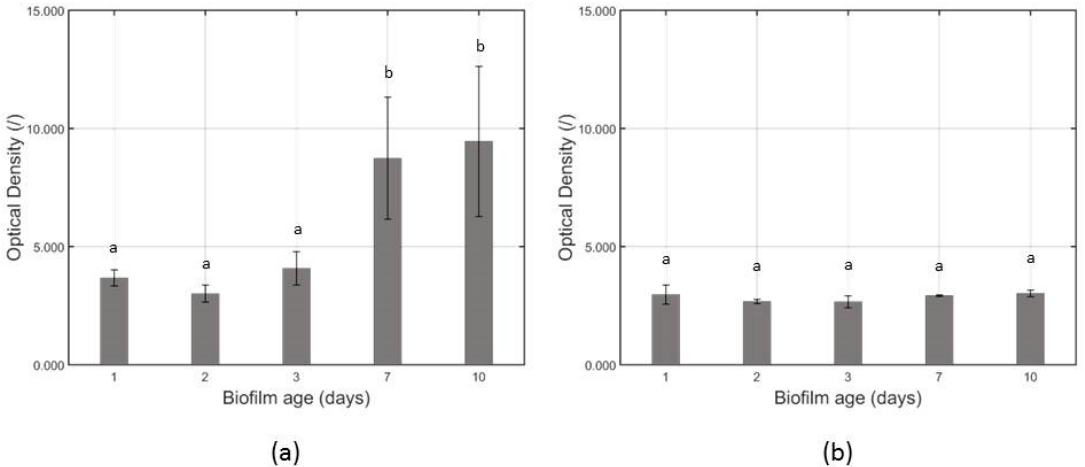
Figure 2. Total biofilm mass, expressed as optical density ( ‐ ), for the untreated ( a ) L. monocytogenes and ( b ) S. Typhimurium biofilms following 1, 2, 3, 7, and 10 day(s) of incubation. For each species, bars bearing different lowercase letters are significantly different ( p ≤ 0.05).